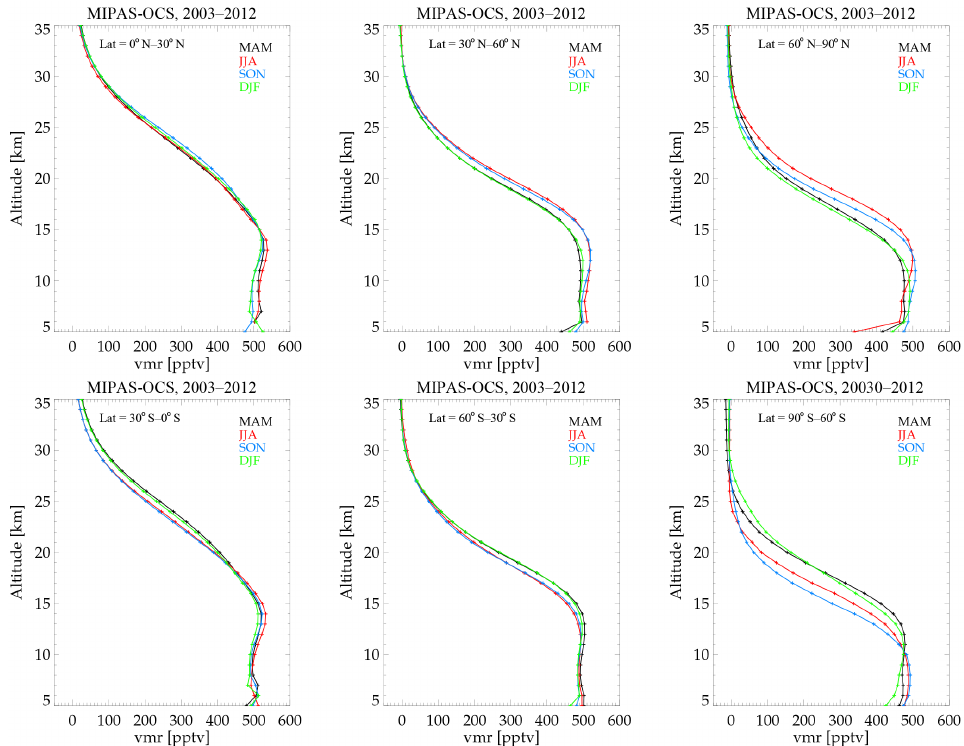
Figure 7. Mean OCS profiles measured by MIPAS in the latitude bands 0–30 ◦ N, 30–60 ◦ N, 60–90 ◦ N, 0–30 ◦ S, 30–60 ◦ S and 60–90 ◦ S (top left to bottom right) during different seasons. Colour coding of seasons: March–May (black), June–August (red), September–November (blue), December–February